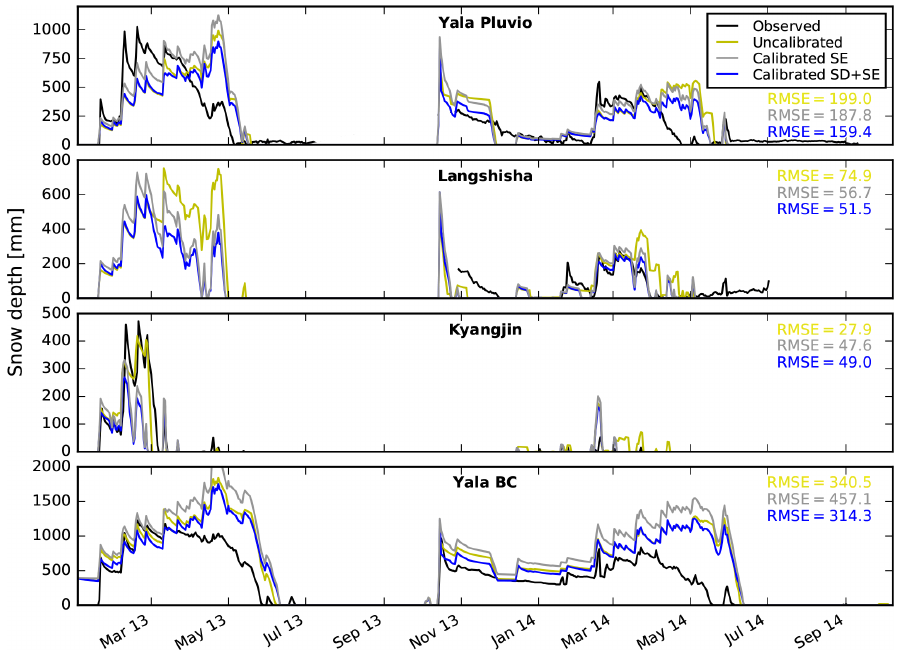
Figure 5. Observed snow depth and modeled snow depth (i) before calibration, (ii) after calibration of snow extent (SE), and (iii) after calibration of both snow extent and snow depth (SD + SE; ensemble mean) at three locations. The RMSE (mm) is given for the fit between modeled (before and after calibration) and observed snow depth.